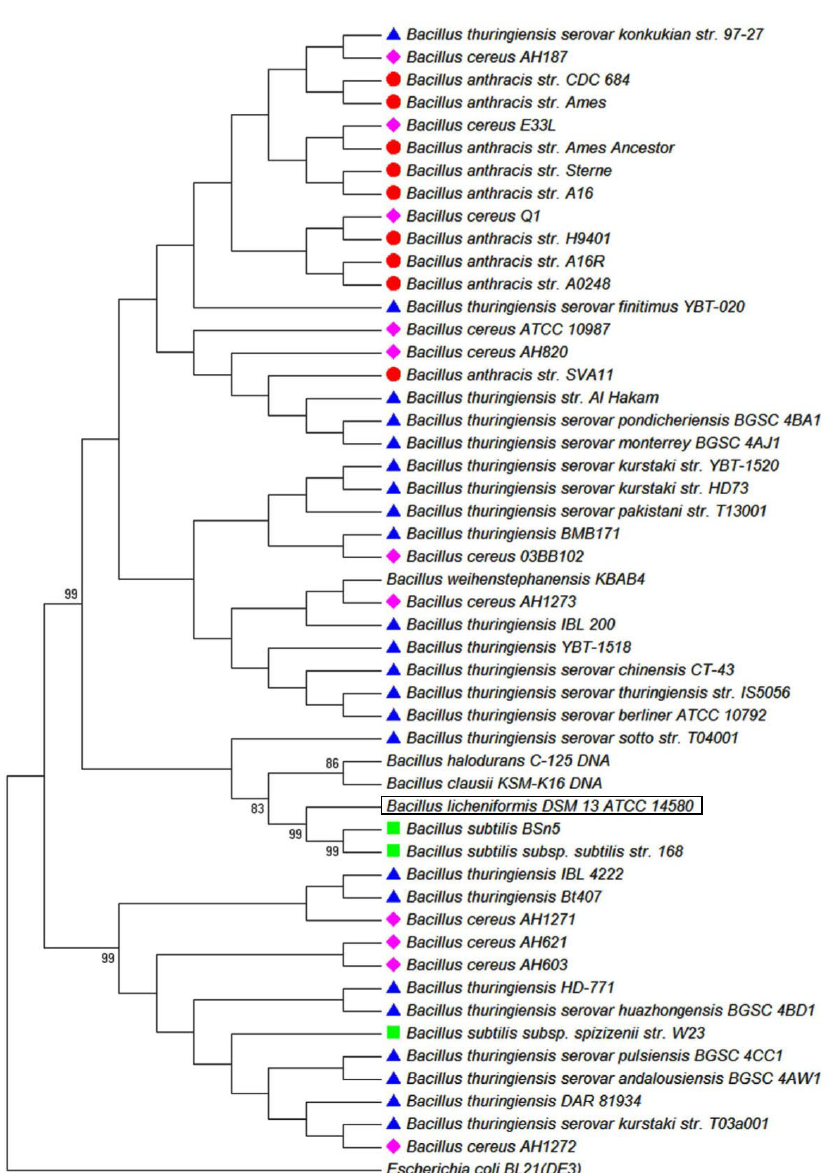
Fig. 2. Phylogenetic tree constructed by Neighbor-joining based on the sequences of the 16S rRNA gene from 50 Bacillus strains (Wang and Ash,